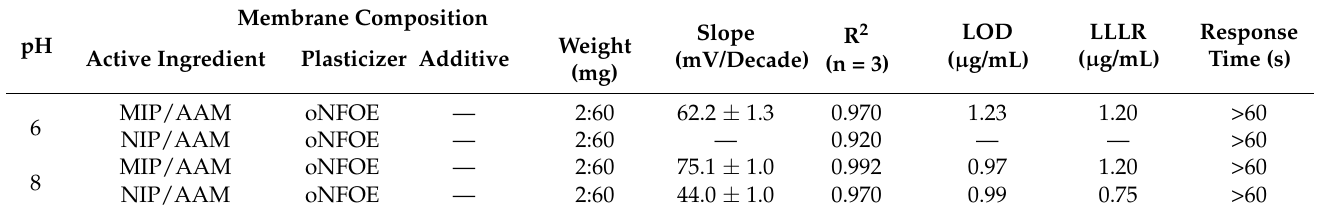
Table 1. Membrane composition of A β -42 sensors casted in 50 mg of PVC and their potentiometric features in 1.0 × 10 − 2 M MOPS buffer, pH 6 and